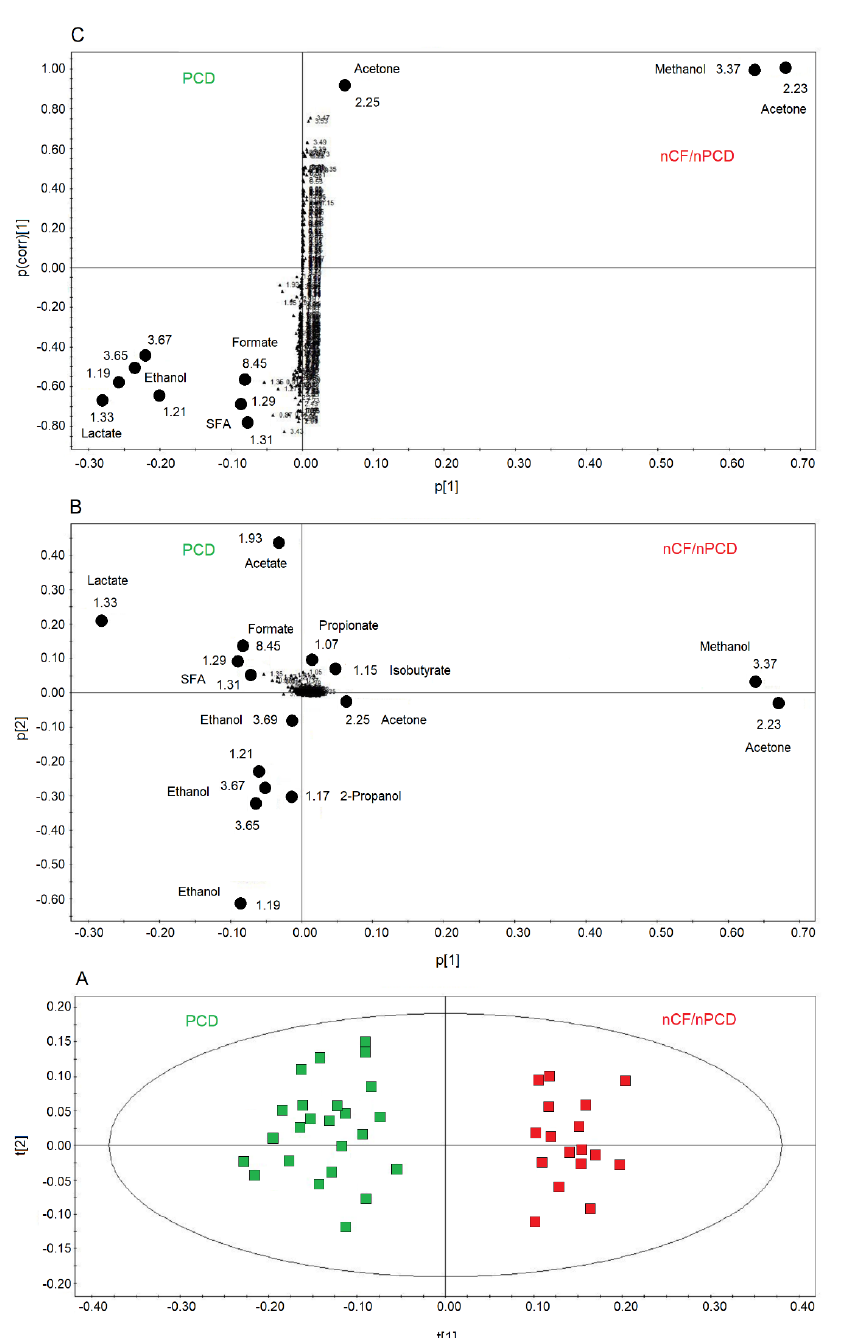
Figure 6. Orthogonal projections to latent structures discriminant analysis (OPLS-DA) of EBC samples for the PCD and nCF / nPCD bronchiectases comparison. ( A ) Scores plot showing the degree of separation of the model considering PCD (green squares) and nCF / nPCD bronchiectases (red squares). The model presents strong regression (95%, p < 0.0001) and high-quality parameters (R 2 = 87.33% and Q 2 = 81.10%). ( B ) Associated loadings plot showing the metabolites responsible for the between-class separation. Numbers refer to buckets’ chemical shifts, and the discriminating metabolites (black dots) are explicitly labeled. ( C ) S-plot reporting the statistically significant [Variable importance in projection (VIP) > 1 and p corr > 0.6] discriminating buckets (black dots). Numbers refer to the chemical shift of